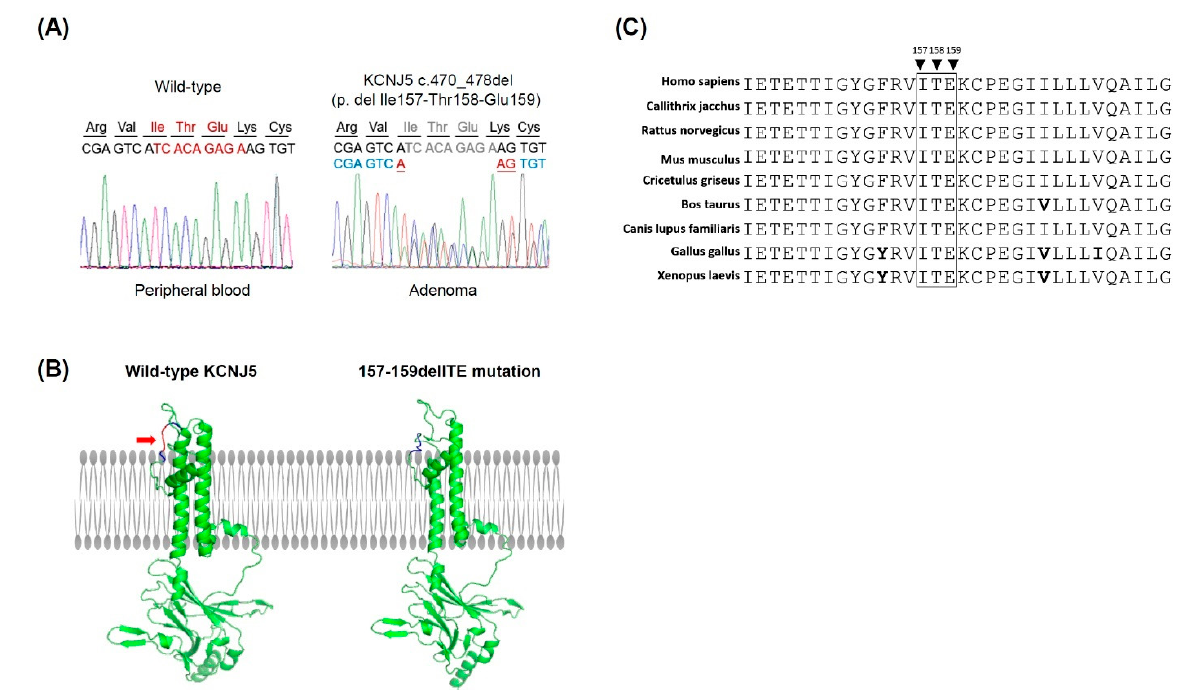
Figure 1 . A somatic mutation in KCNJ5 157-159delITE in aldosterone-producing adenoma. ( A ) Sequences of blood and tumor genomic DNA of KCNJ5 in APA. Of note, KCNJ5 157-159delITE mutation is noted in adenoma but not blood nuclear cells. ( B ) The modeling structure of human KCNJ5 was generated by the Phyre2 web serve. The red color region marked by red arrow in wild-type KCNJ5 indicates the location of isoleucine (Ile, I) 157, threonine (Thr, T) 158 and glutamine (Glu, E)159. The mutation site of 157-159delITE in KCNJ5 is located in the loop region near the selectivity filter of the potassium channel. ( C ) The evolutionary conservation analysis of amino acids I157, T158 and E159 are conserved in different species.